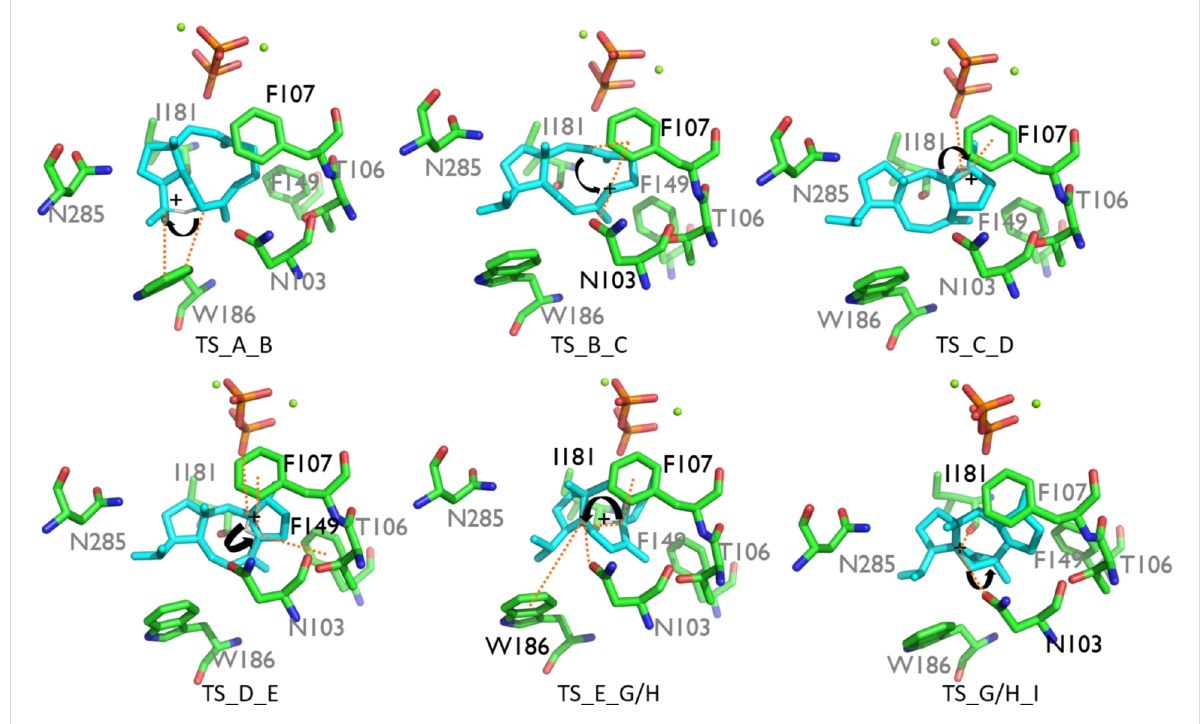
Figure 3: TS structures TS_ A _ B –TS_ G / H _ I in the active site model. Interactions are marked by dashed orange lines, the interacting residues are labeled in black, the non-interacting residues are labeled in grey, and the plus signs note the location of the cations.